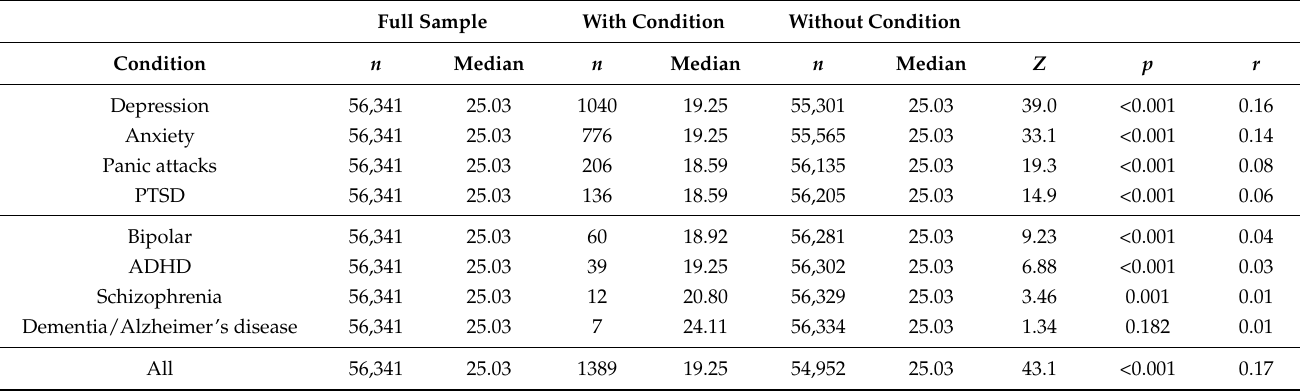
Table 3. Short Warwick–Edinburgh Mental Wellbeing Scale scores for those with and without specific mental health conditions who participated in parkrun as a runner/walker: statistical comparison used the Mann–Whitney U test.